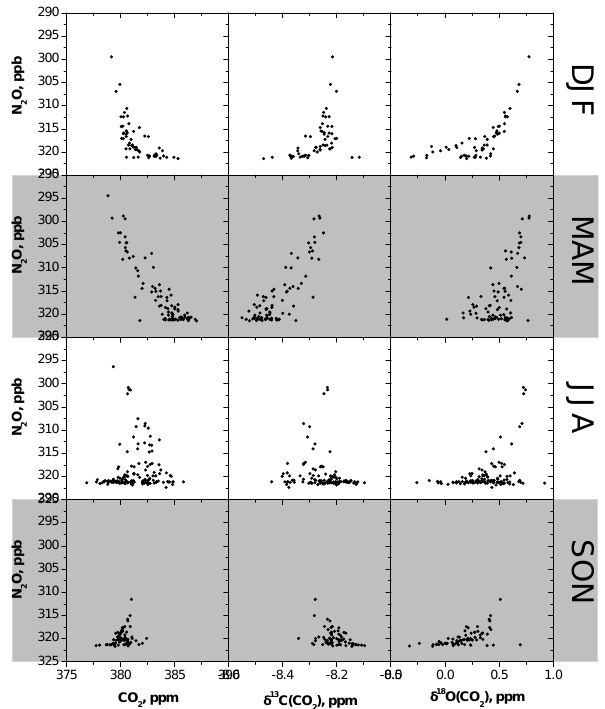
Fig. 6. CARIBIC-2 CO 2 isotope data separated into 4 different seasons and plotted vs. the stratospheric tracer N 2 O. Plotted are lat- itudes above 35 ◦ N where UT/LMS mixing takes place. Seasonal variability of UT/LMS trends observed is governed mostly by vari- ability in the UT